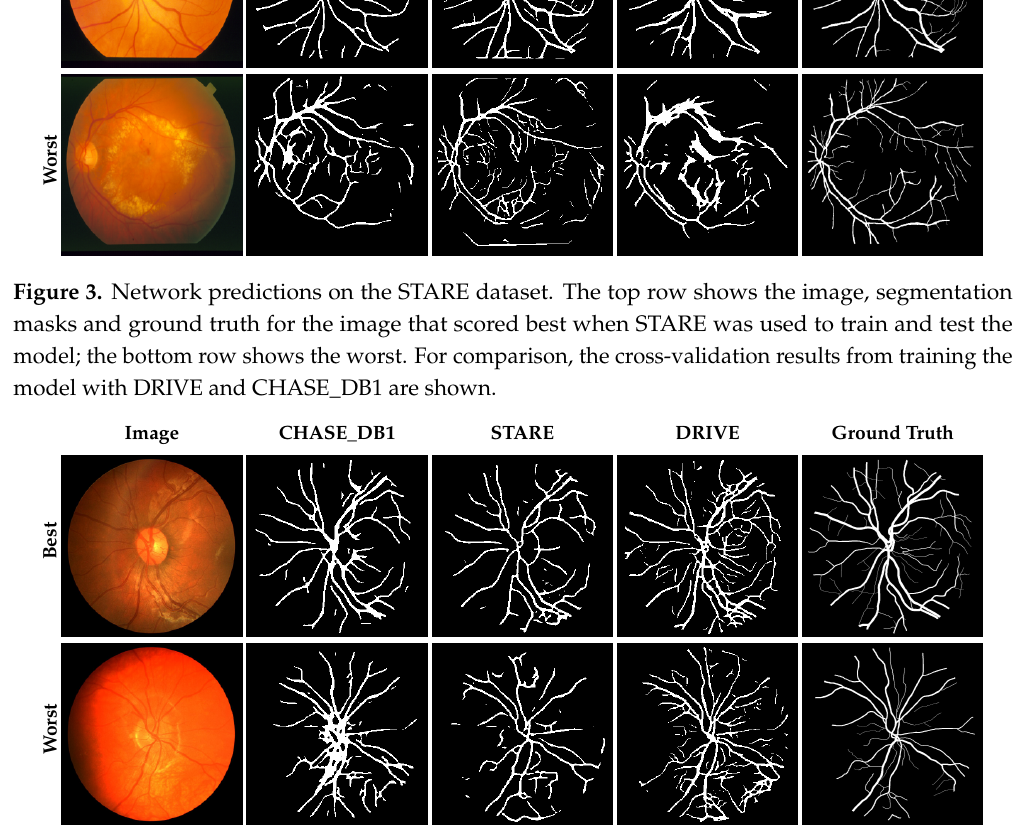
Figure 4. Network predictions on the CHASE_DB1 dataset. The top row shows the image, segmentation masks and ground truth for the image that scored best when CHASE_DB1 was used to train and test the model; the bottom row shows the worst. For comparison, the cross-validation results from training the model with STARE and DRIVE are shown. Table 7. Computation times for different networks using an NVIDIA Titan